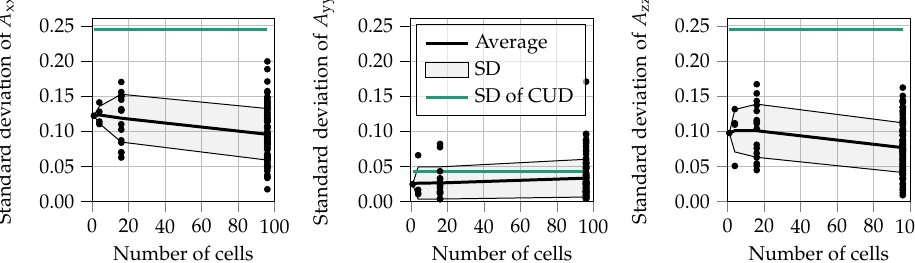
Figure 6. Standard deviations of fiber orientation components A xx , A yy and A zz of the back walls of Configuration A shown in Figure 5 for different evaluation meshes compared with the standard deviation of a continuous uniform distribution (green). The mean standard deviation of the fiber orientation component is displayed as a solid line, and the standard deviation of the standard deviation is drawn as gray area to indicate the scatter of the